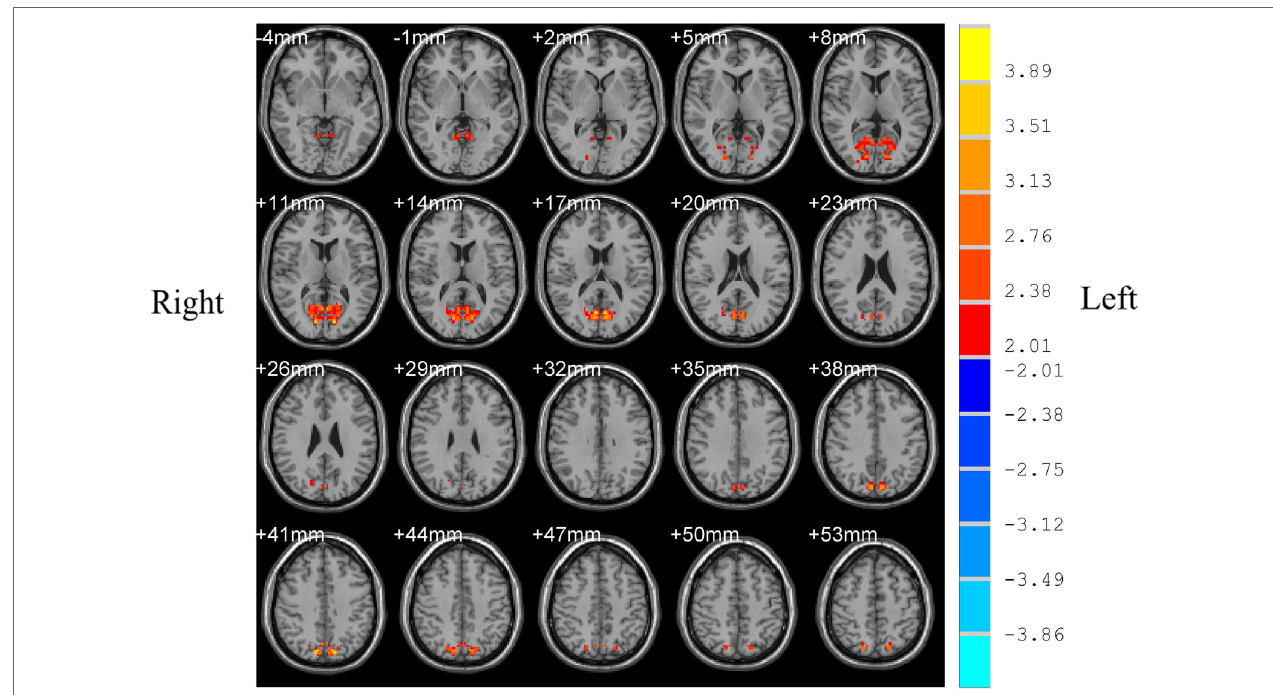
FigUre 1 | Shown is a significantly increased voxel-mirrored homotopic connectivity (VMHC) in obstructive sleep apnea–hypopnea syndrome patients as compared with controls. Thresholds are set at a corrected P < 0.05, as determined by Monte Carlo simulation. Red indicates increased VMHC. The left side of the images represents the right of the brain and vice versa .